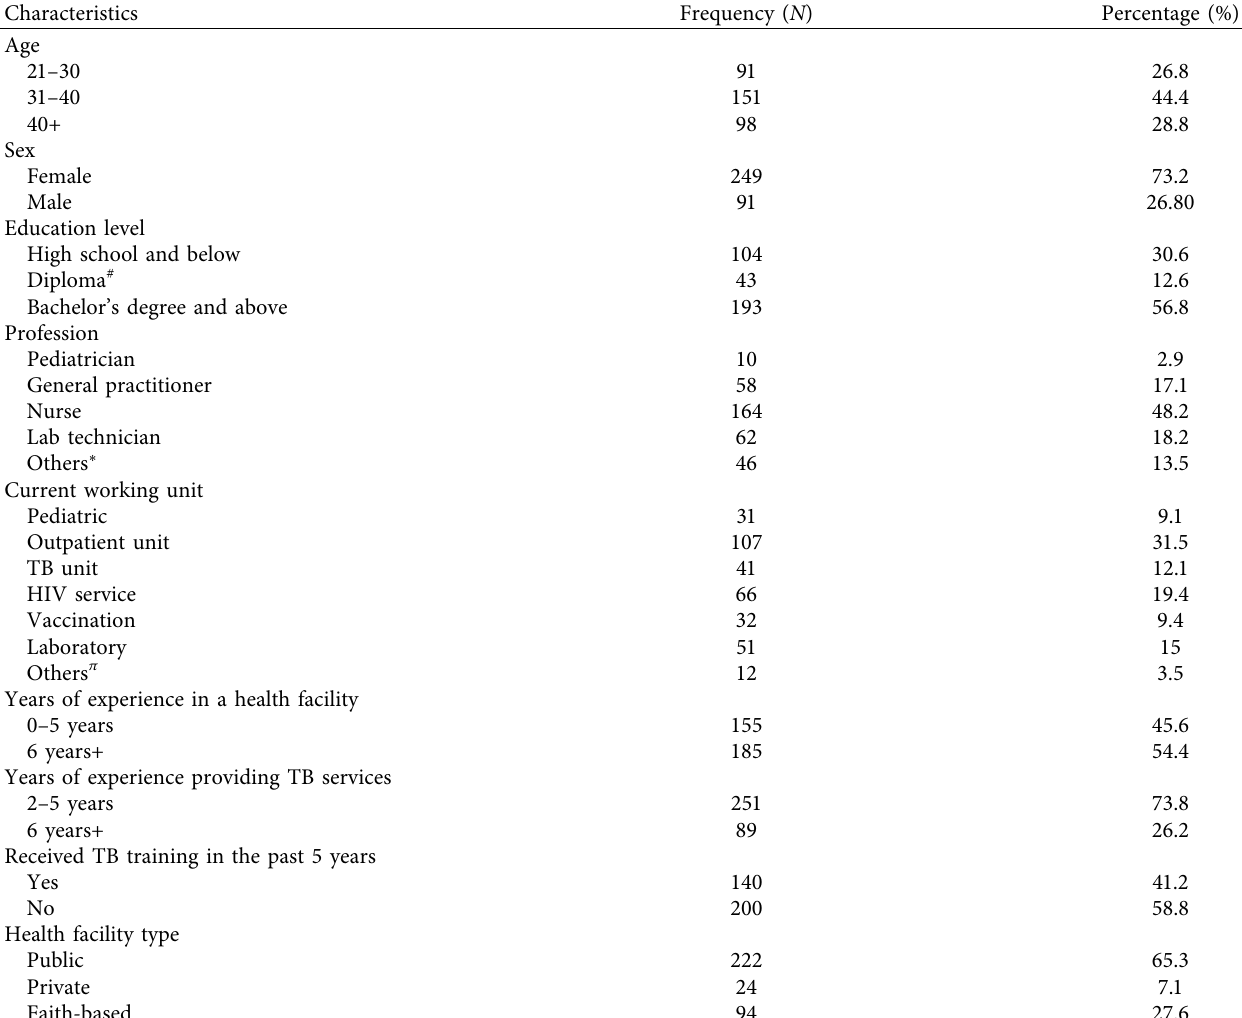
Table 1: Sociodemographic characteristics of the study